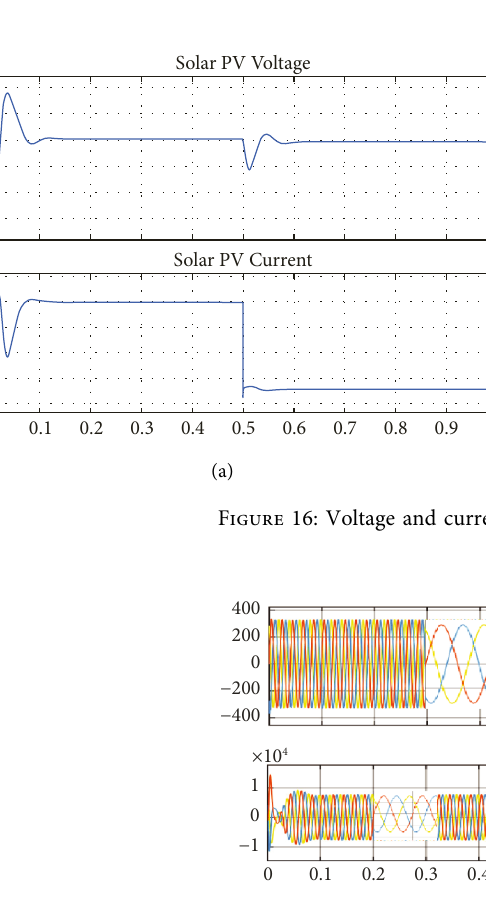
Figure 15: Output power ANN trained by (a) PSO and (b)